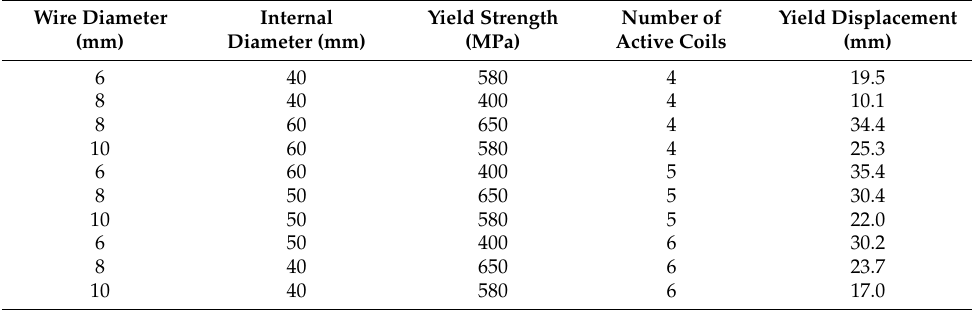
Table 2. Input and output patterns of ANN1.